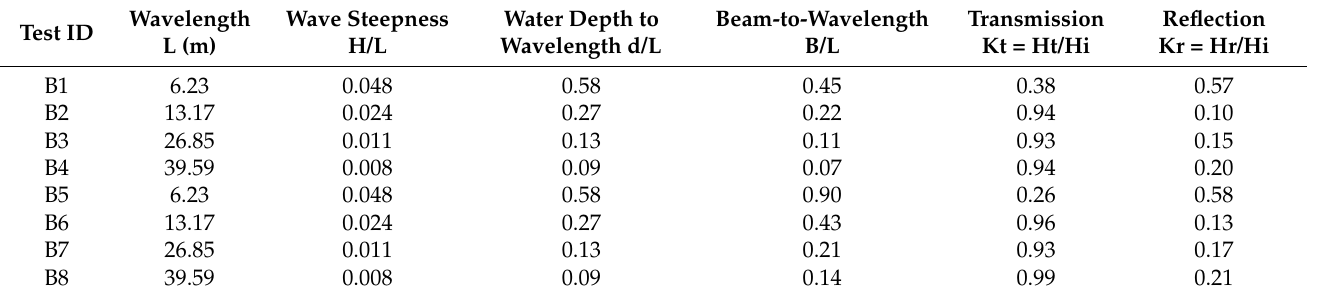
Table 5. Monochromatic Wave Testing Results Including Transmission and Reflection Coefficients (Prototype Scale).